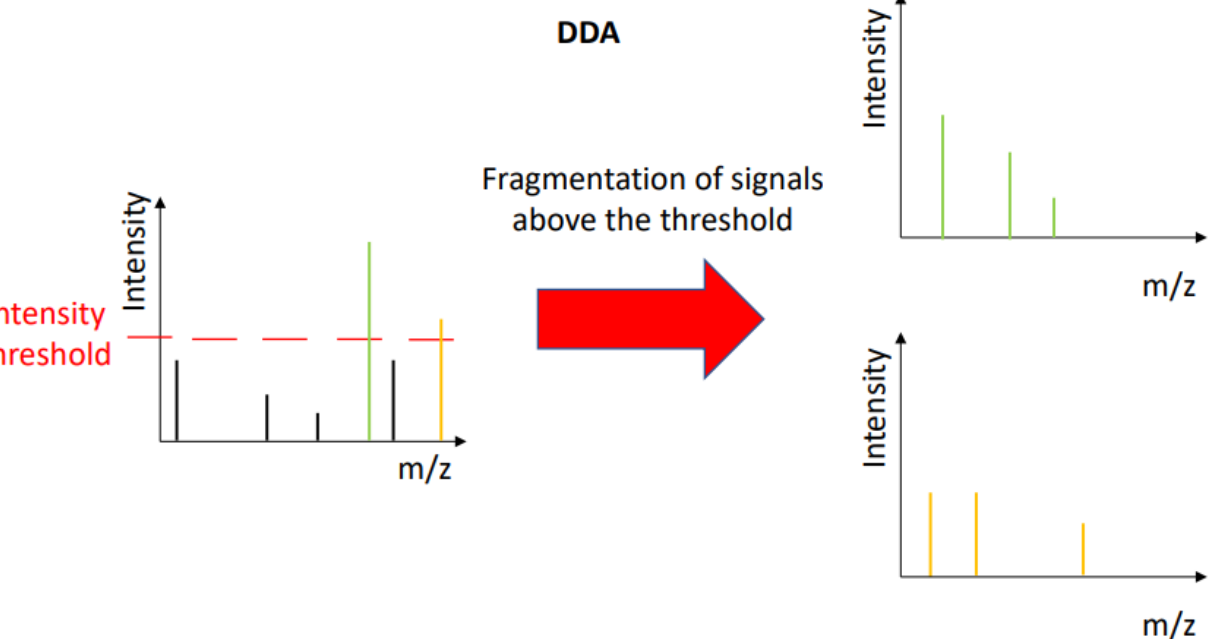
Figure 3. Schematic of DDA fragmentation of two compounds (green and yellow).